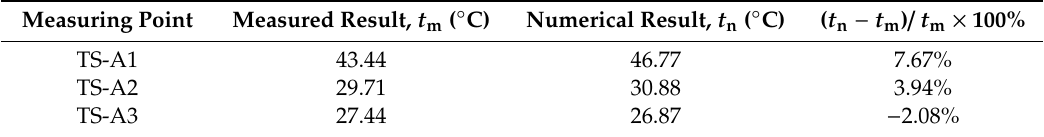
Table 2. Comparison of initial temperatures based on monitoring and numerical